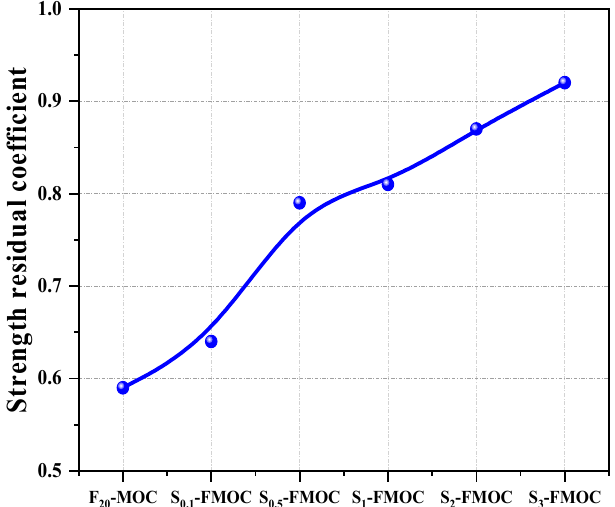
Figure 11. Strength residual coefficient of composite material–magnesium oxychloride cement composite ternary system after water immersion.